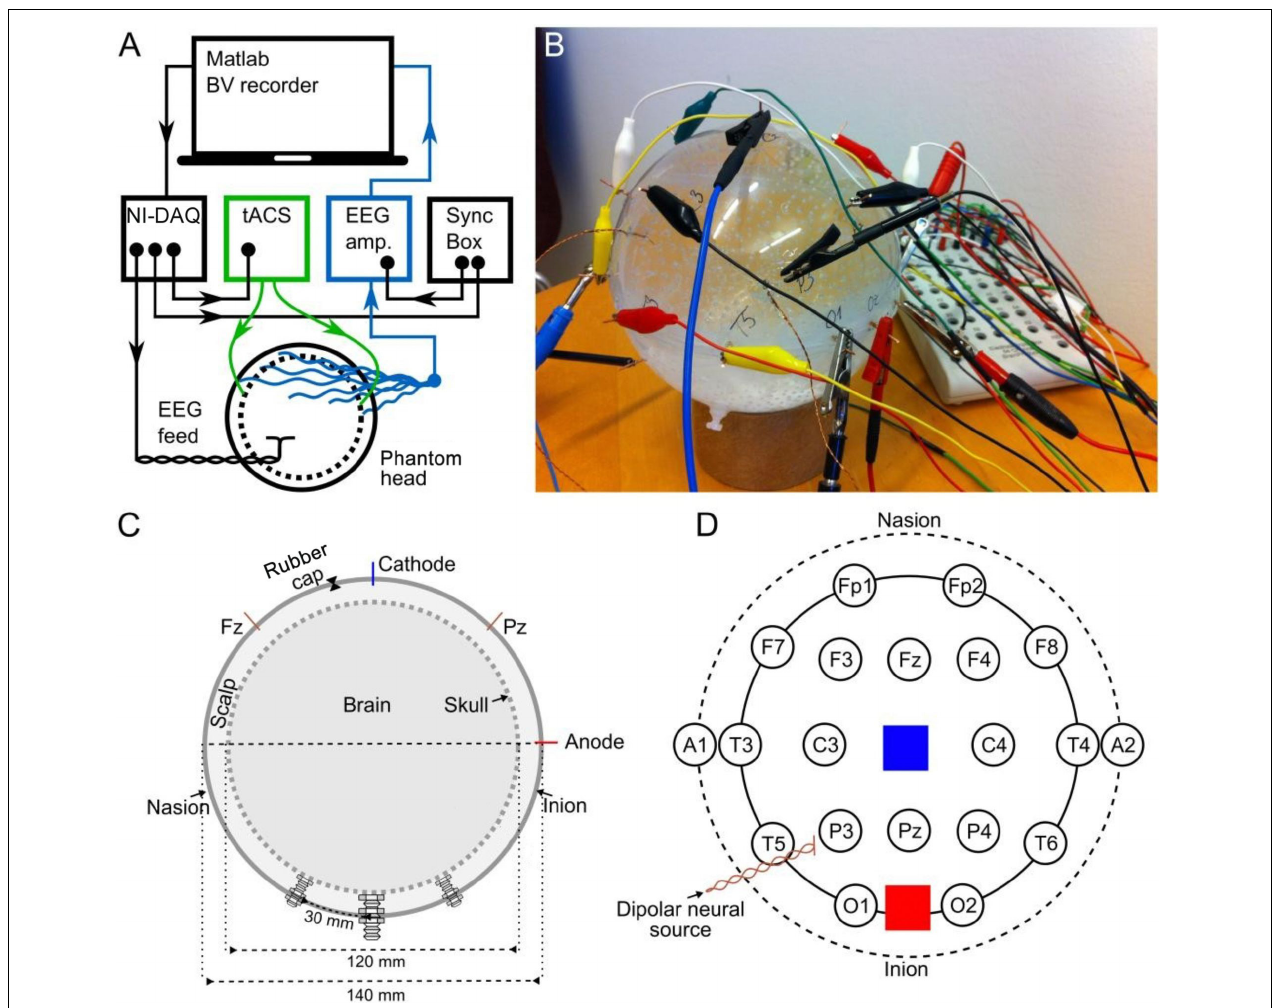
FIGURE 1 | Experimental set-up and the structure of the phantom. (A) Schematic illustration of the hardware setup as well as the signal delivery and recording (BV recorder: Brain Vision EEG recording software; NI-DAQ: National Instruments digital-to-analog converter). Arrowheads indicate the direction of information flow. (B) Photo of the phantom head. (C) Cross section of the phantom head along the midline. The dashed inner circle shows the inner porous spherical shell (skull), and the outer circle shows the outer spherical shell confining the scalp. Both the inner and outer shells were 2 mm thick. (D) Stereographic projection of the phantom from above, depicting locations of EEG (circles) and tACS electrodes (blue and red squares), and the dipolar